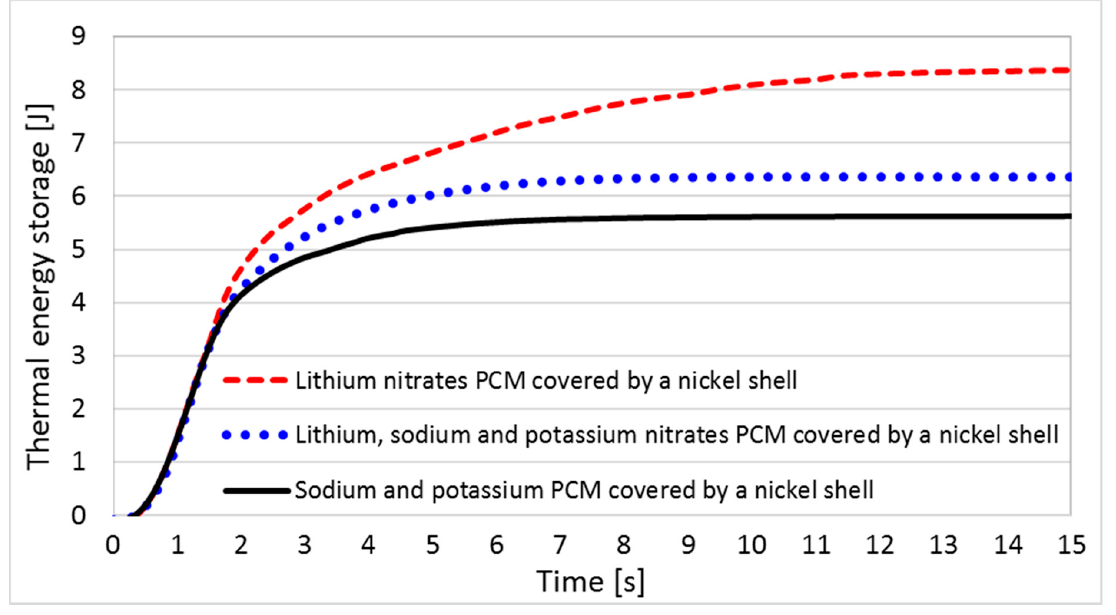
Figure 2. EPCMs thermal energy as a function of the time.